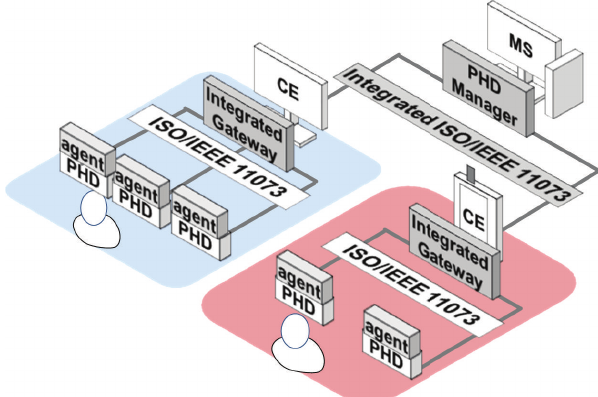
Figure 2: Architecture of the proposed u-healthcare